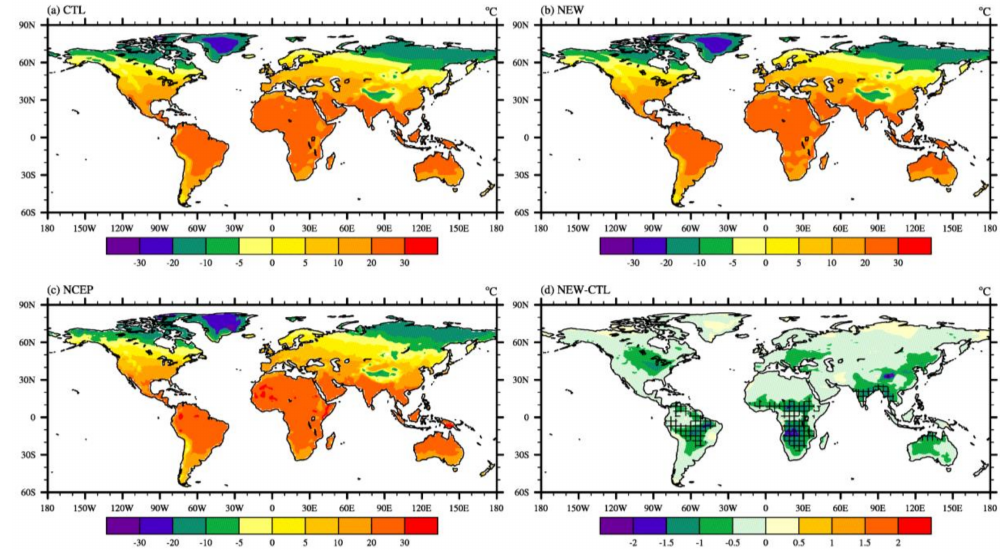
Figure 6. Twenty-four-year (1982–2005) mean 2-m air temperature (TA, ◦ C) from ( a ) the CTL run; ( b ) the NEW run; ( c ) NCEP data; ( d ) the difference between NEW and CTL. (Grid shaded regions are significant at the 95% confidence level according to Student’s t